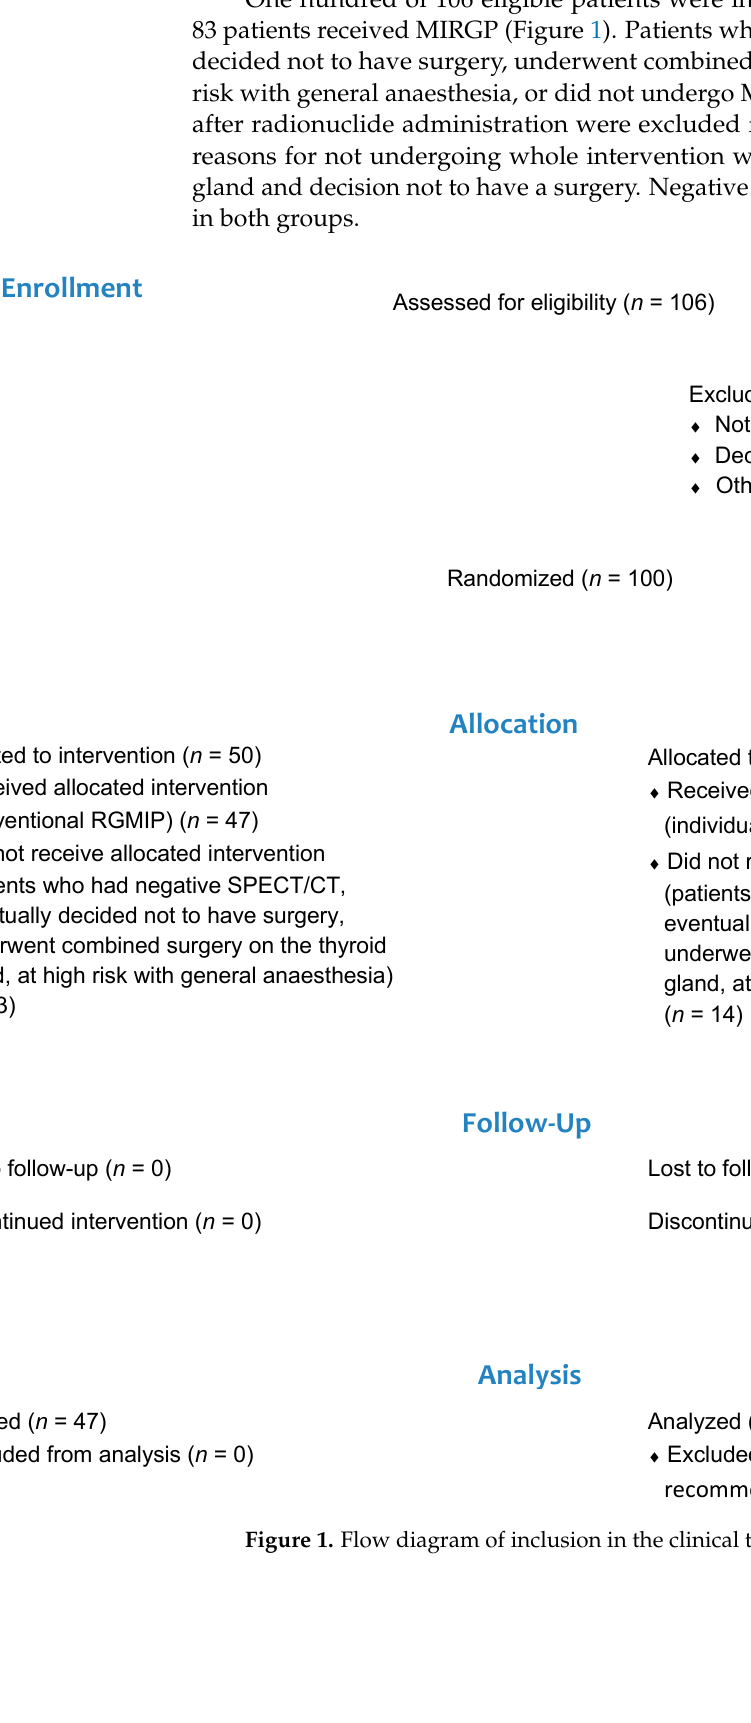
Figure 1. Flow diagram of inclusion in the clinical trial.